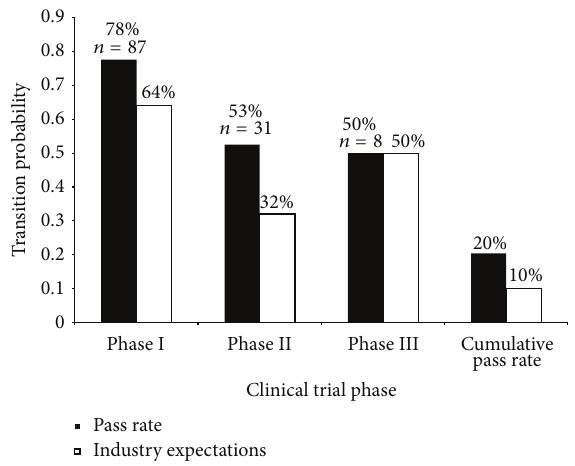
Figure 2: Clinical trial failures. The causes of clinical trial failures in the development of hepatitis C drugs are divided into medical failures and commercial failures. The number of drugs contributing to each type of failure in each clinical trial phase is shown. The total number of drug compounds that have passed the phase is depicted for